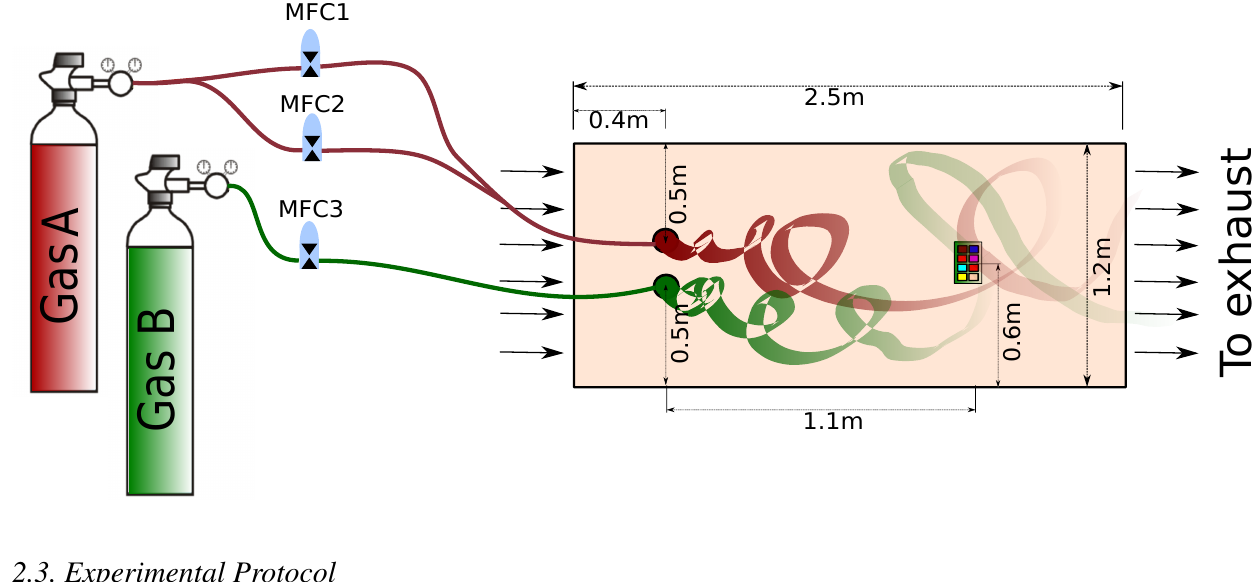
Figure 2. The developed experimental setup can generate two independent plumes. The set of mass flow controllers (MFCs) controls the flow at which the gases are released at each source. The detection platform is exposed to the resulting turbulent gas mixture, while the air carries the emitted molecules towards the exhaust outlet. Two MFCs command the gas flow released at source1 to increase the maximum flow. The MFC configuration allows accurate adjustment of released flows to make the induced sensors’ responses of the same order of